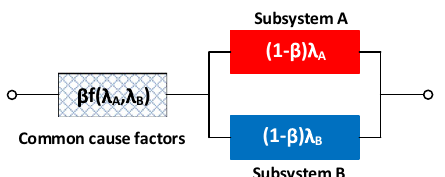
Fig. 4 Reliability block diagram model of ‘one-out-of-two’ system incorporating CCF based on the β-factor model